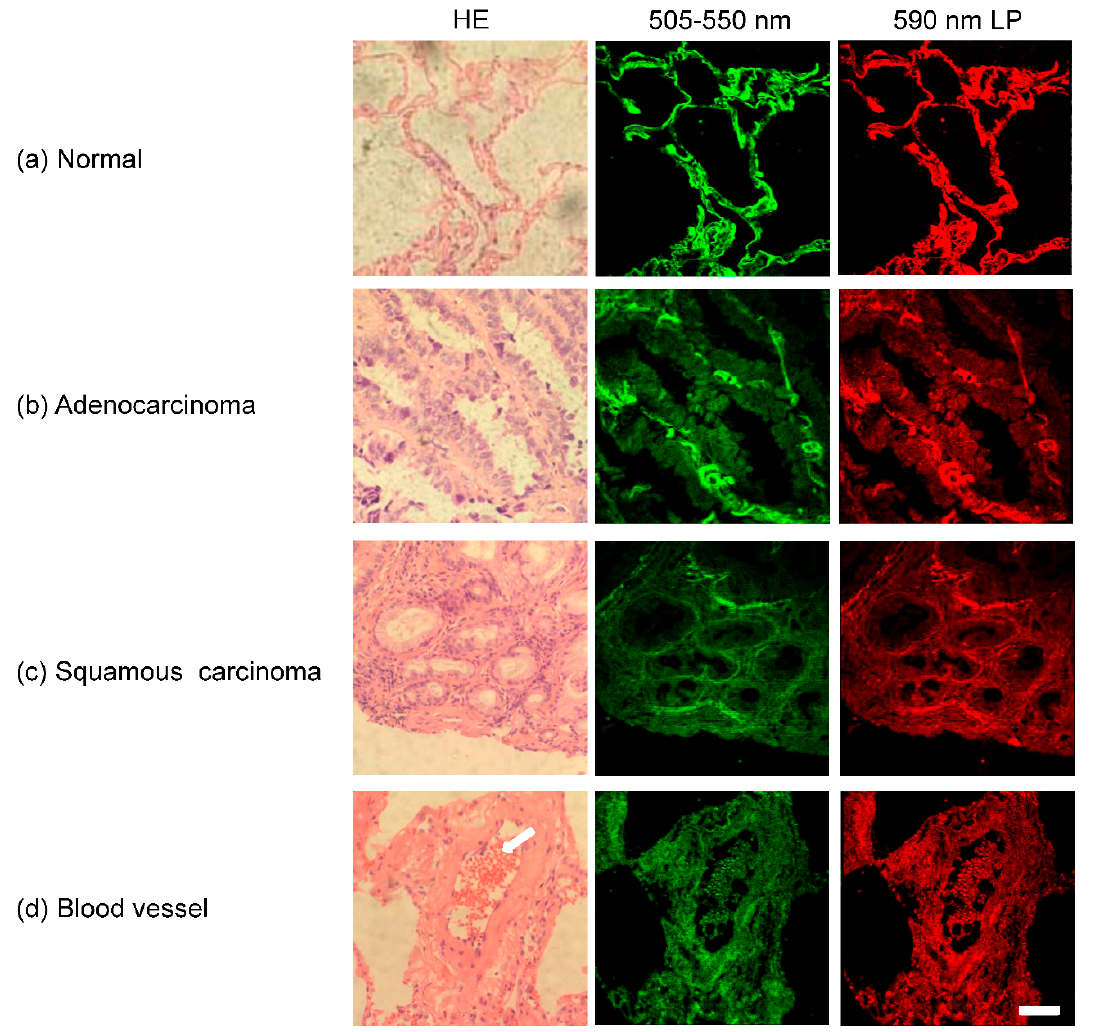
Figure 1. HE and autofluorescence images of lung tissue samples: ( a ) normal tissue; ( b ) adenocarcinoma; ( c ) squamous carcinoma; and ( d ) blood vessel in lung tissue. Scale bar is 50 µ m. To study the fluorescence imaging capability on thick tissues, the 3D images of two samples were acquired and shown in Figure 2a,b; normal tissue and cancerous tissue. The cellular morphology features were clearly different between normal and cancerous tissue from the surface of the tissue (0 µ m) down to the deep position ( − 24 µ